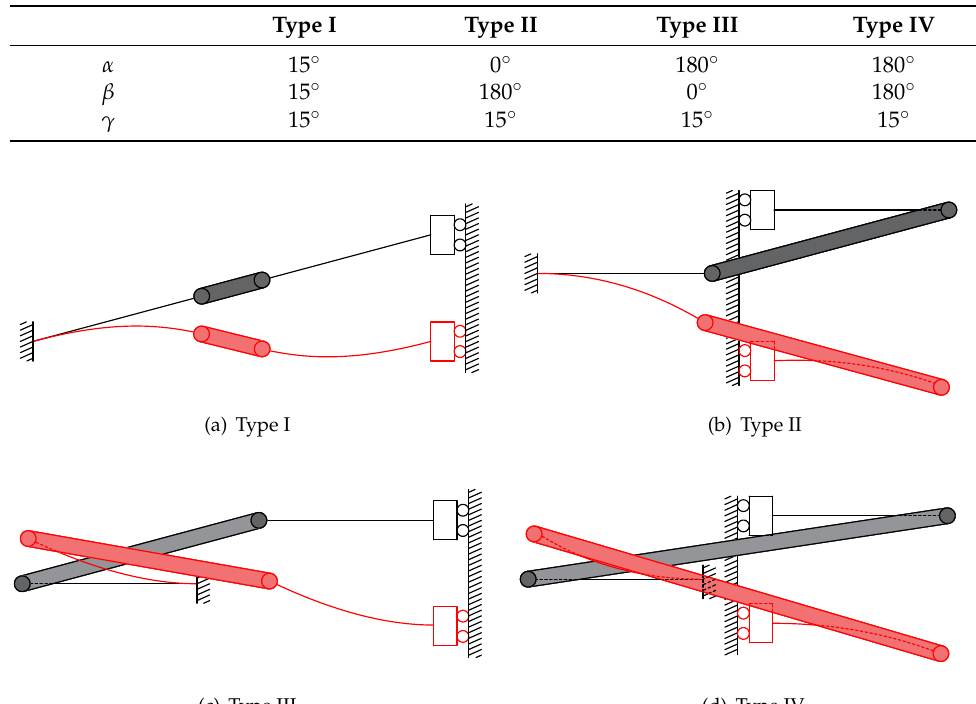
Table 1. The angle parameters of compliant bistable mechanisms.